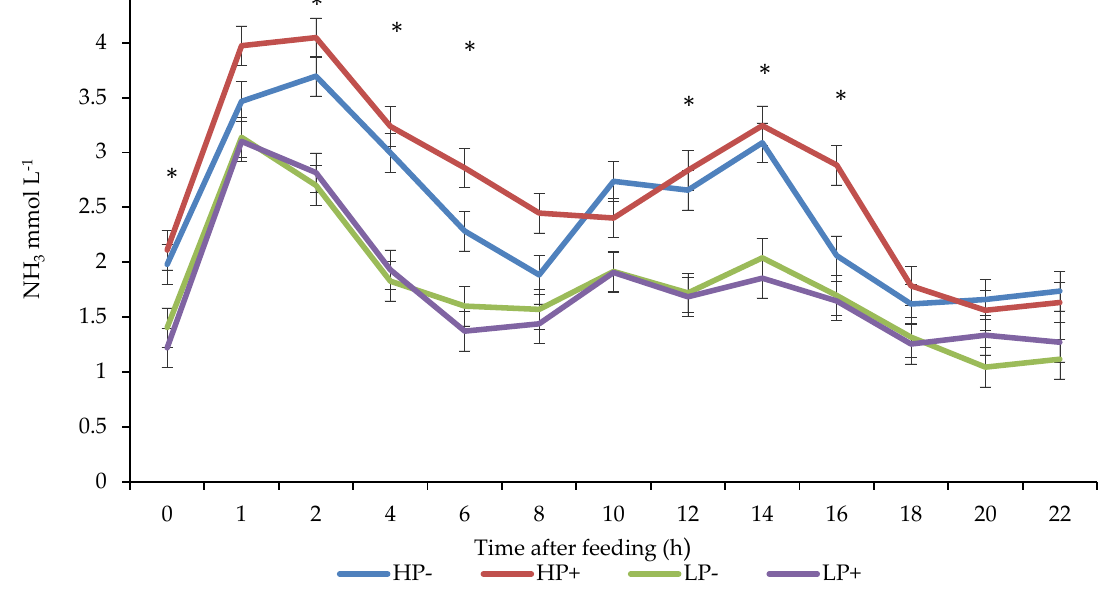
Figure 2. Effect of chitosan inclusion and level of crude protein on ruminal ammonia concentrations. * Denotes significance at time points between HP and LP. Crude protein × chitosan p < 0.01; crude protein p < 0.01; chitosan p < 0.05; time after feeding p < 0.001.